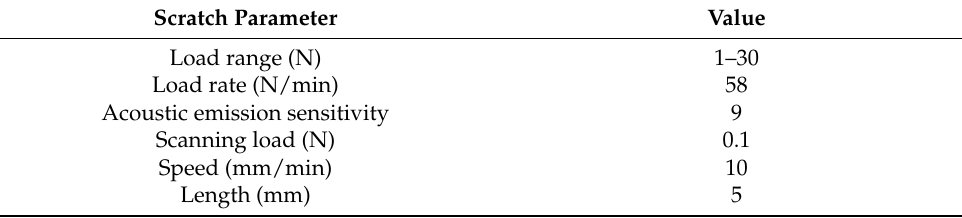
Figure 5. Micro-scratch test results. Table 4. Parameters of micro-scratch